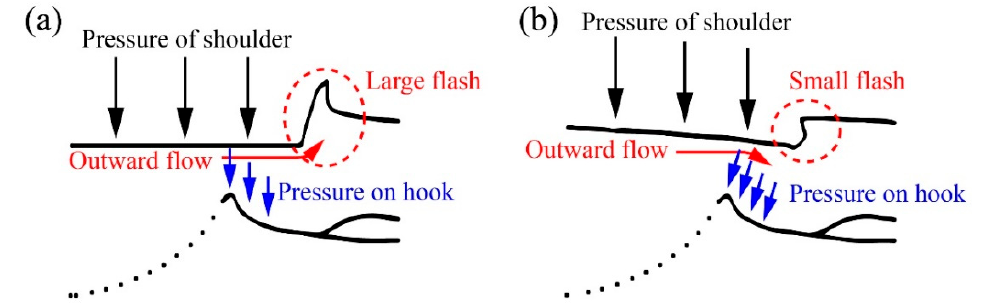
Figure 13. Schematic illustrations of the interaction in the P-FSSW process with the ( a ) flat tool and ( b ) concave tool.